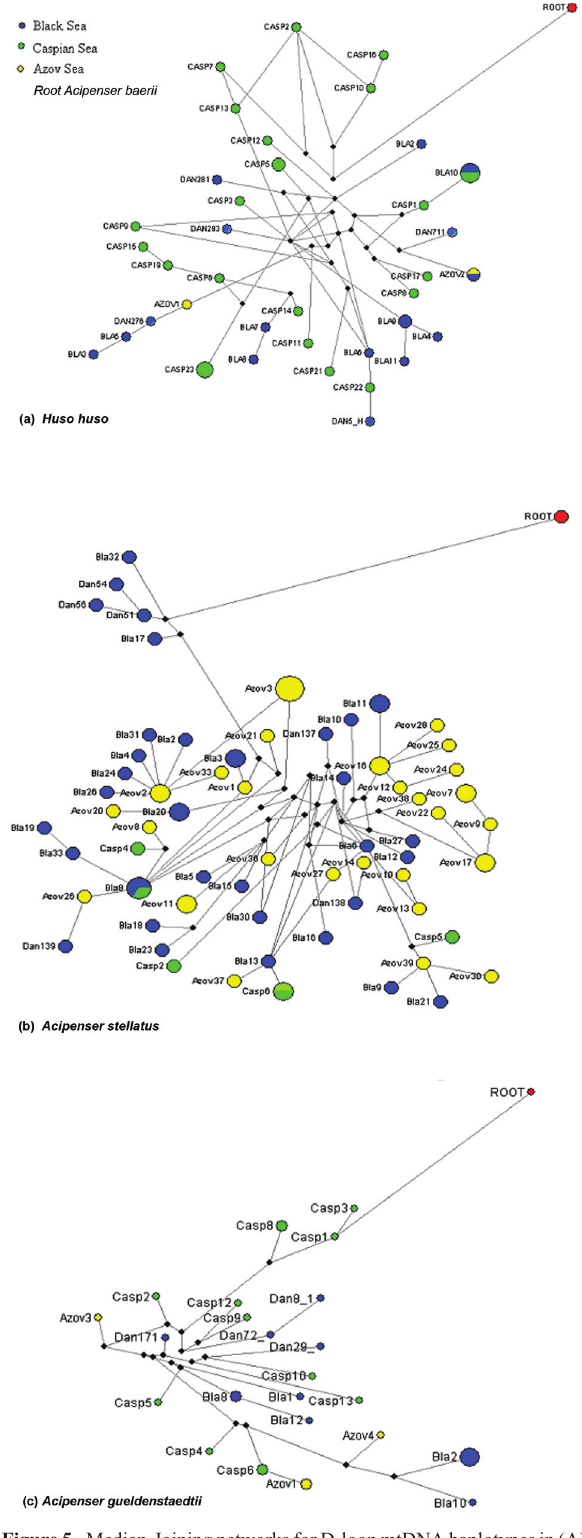
Figure 4 - Molecular phylogenetic trees inferred by partial D-loop se- quences analysis by Neighbor-Joining (A) and Maximum Likelihood (B) in H. huso constructed using the Tamura3 parameter plus G model with 1000 bootstrap iterations. ROOT indicates the outgroup species A. baerii (NC_017603). The numbers represent the confidence bootstrap values higher than 50. Bla= Black Sea; Casp = Caspian Sea; Azov = Azov Sea.